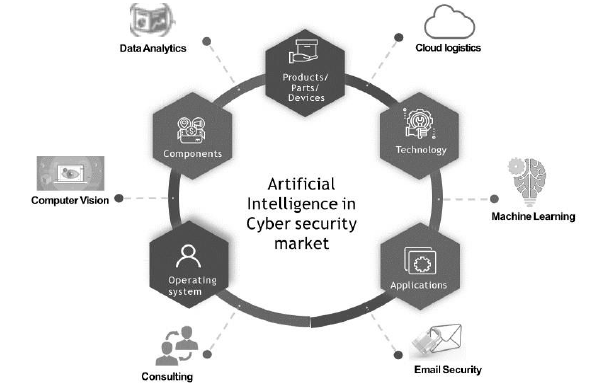
Figure 1. Application of Artificial Intelligence